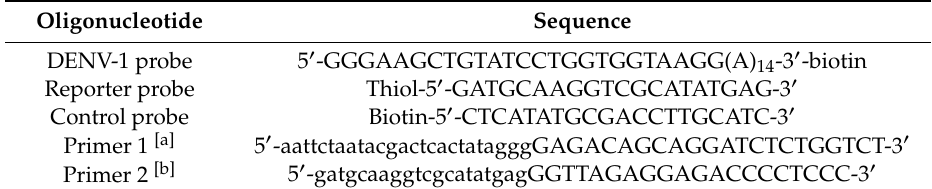
Table 1. DNA sequences of probes and primers used in this